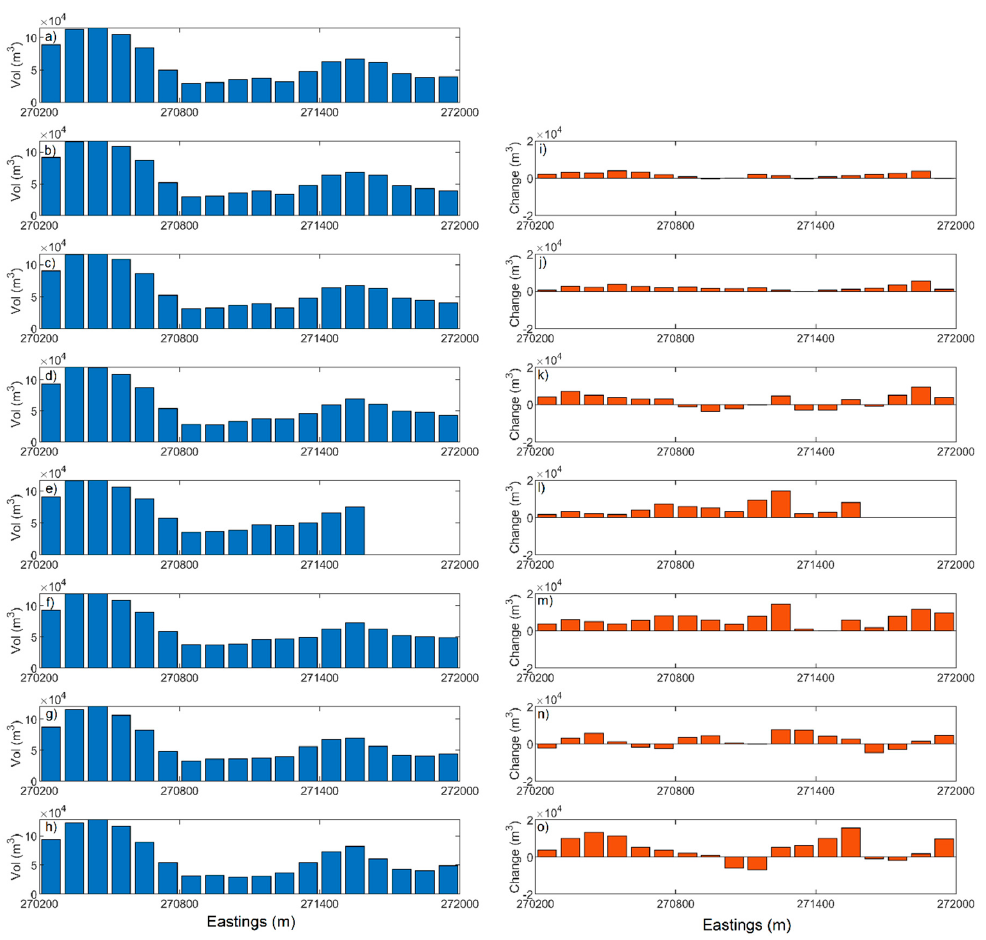
Figure 9. Dune volumes for ( a ) 24 October 2018; ( b ) 16 November 2018; ( c ) 19 January 2019; ( d ) 25